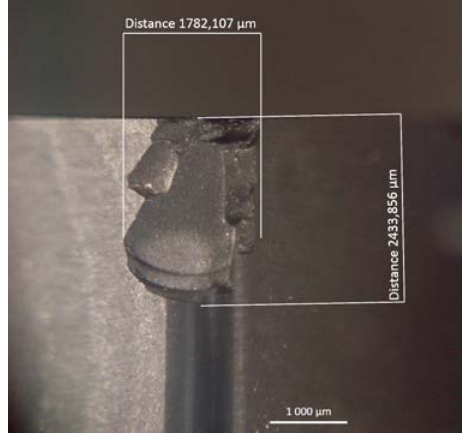
Fig. 1. Brittle fracture (cracking) of the ceramic cutting tool during the milling